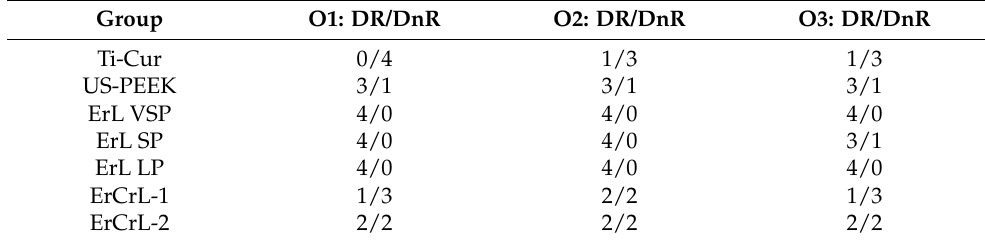
Table 2. Implant debridement visual index